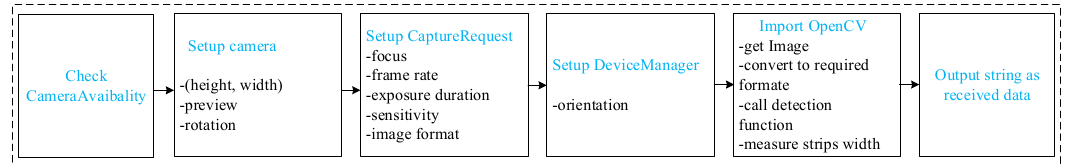
Figure 4. Procedure for getting and processing images in Android Studio using OpenCV.